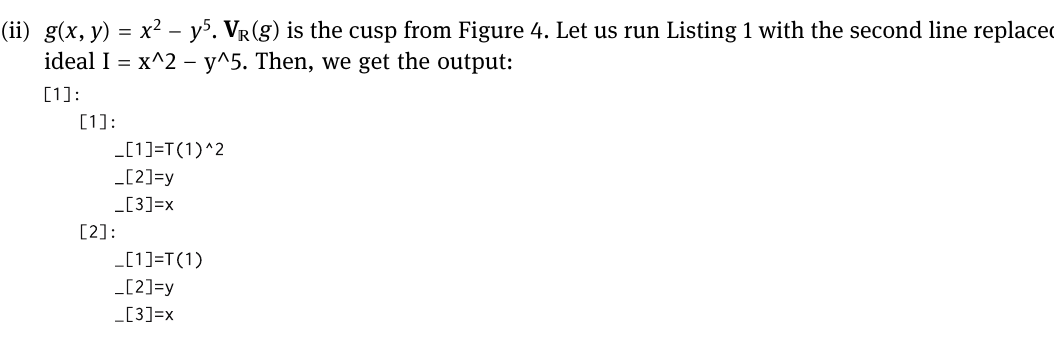
is plotted in Figure 5. Listing 1 with the second